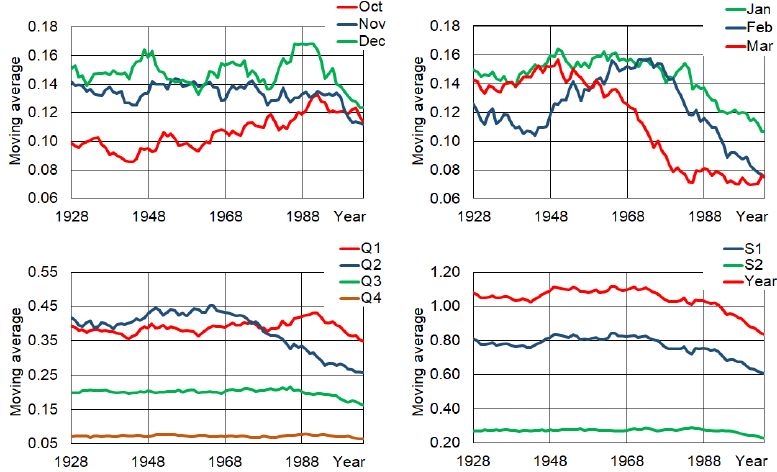
Figure 9. Dimensionless moving average of the rainfall in different periods of the year, from 1913/1914 on, for a running length of 30 years. Each moving was made dimensionless by reference to the mean annual rainfall and assigned to the first civil year of the 16th hydrological year of the corresponding 30-year